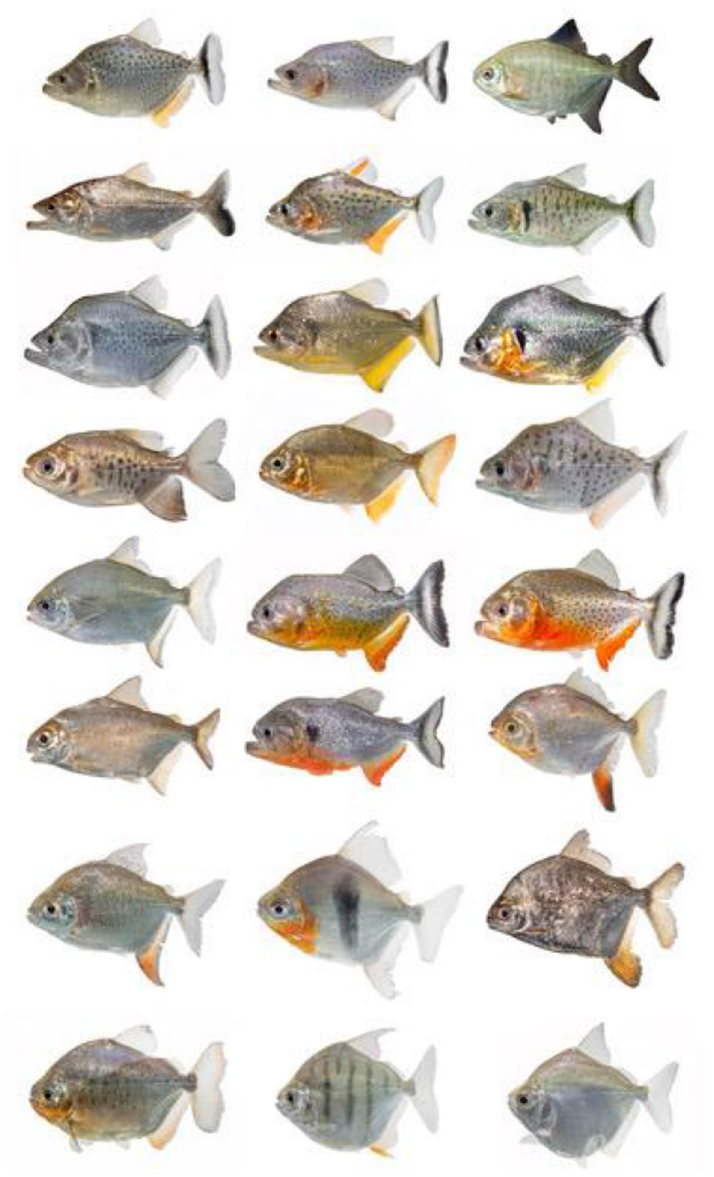
Figure 1. Example of serrasalmid diversity from seven regions: Amazon Lowlands, Orinoco, Pantanal, Tapajos, Tocantins, Araguaia, and Xingu. Species shown include both piranhas and pacus. Species names omitted to illustrate the challenge with identification due to the similarity among species. Photographs taken under standardized conditions as white screen photographs which emphasize the color and pattern of each taxon. Under non-ideal conditions of observation species are more difficult to differentiate (see Figure